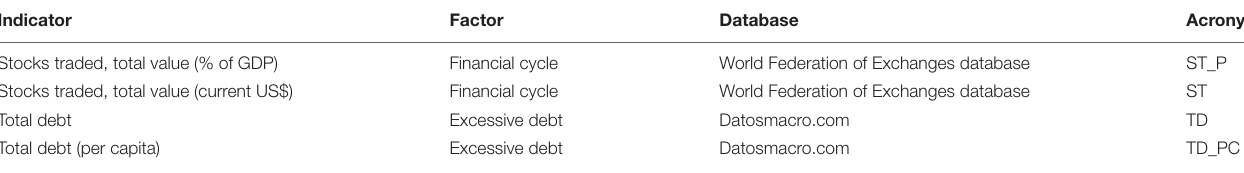
TABLE 2 | Variables corresponding to the short-term factors explaining secular stagnation.